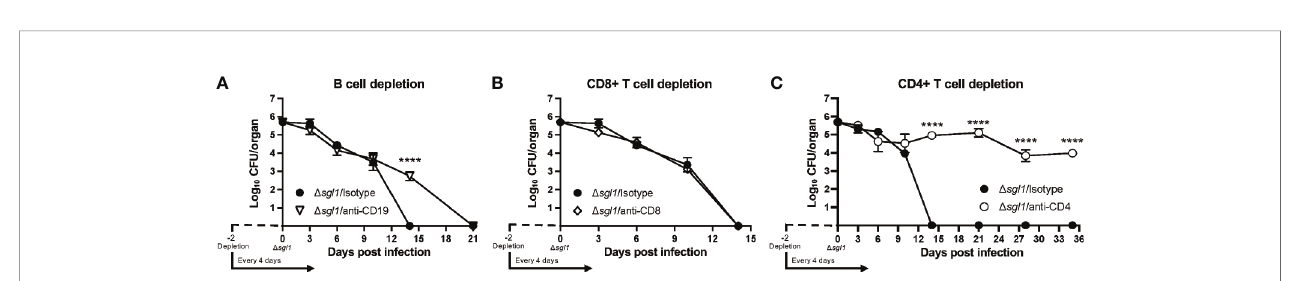
FIGURE 3 | C. neoformans (Cn) D sgl1 induces an increased recruitment of effector leukocyte and is cleared from the lung during combined immunosuppression. (A, B) Mice were intranasally injected with either 5x10 5 Cn WT (black dots) or Cn D sgl1 (white dots) and CD45 + leukocytes (A) or neutrophils (B) were quanti fi ed at various timepoints during the infection. (C) Lung fungal burden during inoculation with Cn D sgl1 treated with either anti-Ly6G (neutrophil depleted) or isotype (control) antibody. (D) Monocytes were quanti fi ed in conditions of immunocompetentency (isotype antibody) or immunode fi ciency (depletion antibody) after inoculation with Cn D sgl1 (E) Lung fungal burden during infection with Cn D sgl1 treated with either anti-Gr1 (monocyte and neutrophil depleted) or isotype (control) antibody. (F) Alveolar macrophages were quanti fi ed in conditions of immunocompetentency or immunode fi ciency after inoculation with Cn D sgl1. (G) Lung fungal burden during infection with Cn D sgl1 treated with either clodronate liposomes (alveolar macrophage depleted), clodronate and anti-Gr1 (alveolar macrophage, monocytes and neutrophil depletion), or isotype antibody/vehicle liposomes (control). All details of dosing frequency, antibody clone, or clodronate liposome con fi guration can be found in the material and methods section. Data shown represent the mean ± SD using 3 mice/group/timepoint. Signi fi cance was detemnined by a two-way ANOVA using S ̌ ı ́ da ́ k ’ s multiple comparisons test for P value adjustment. For (G) , signi fi cance shown de fi nes the comparison between D sgl1 /Vehicle/Isotype and D sgl1 / Clodronate/Isotype. Signi fi cance is denoted as * P < 0.05; ** P < 0.01; *** P < 0.005; **** P < 0.001.